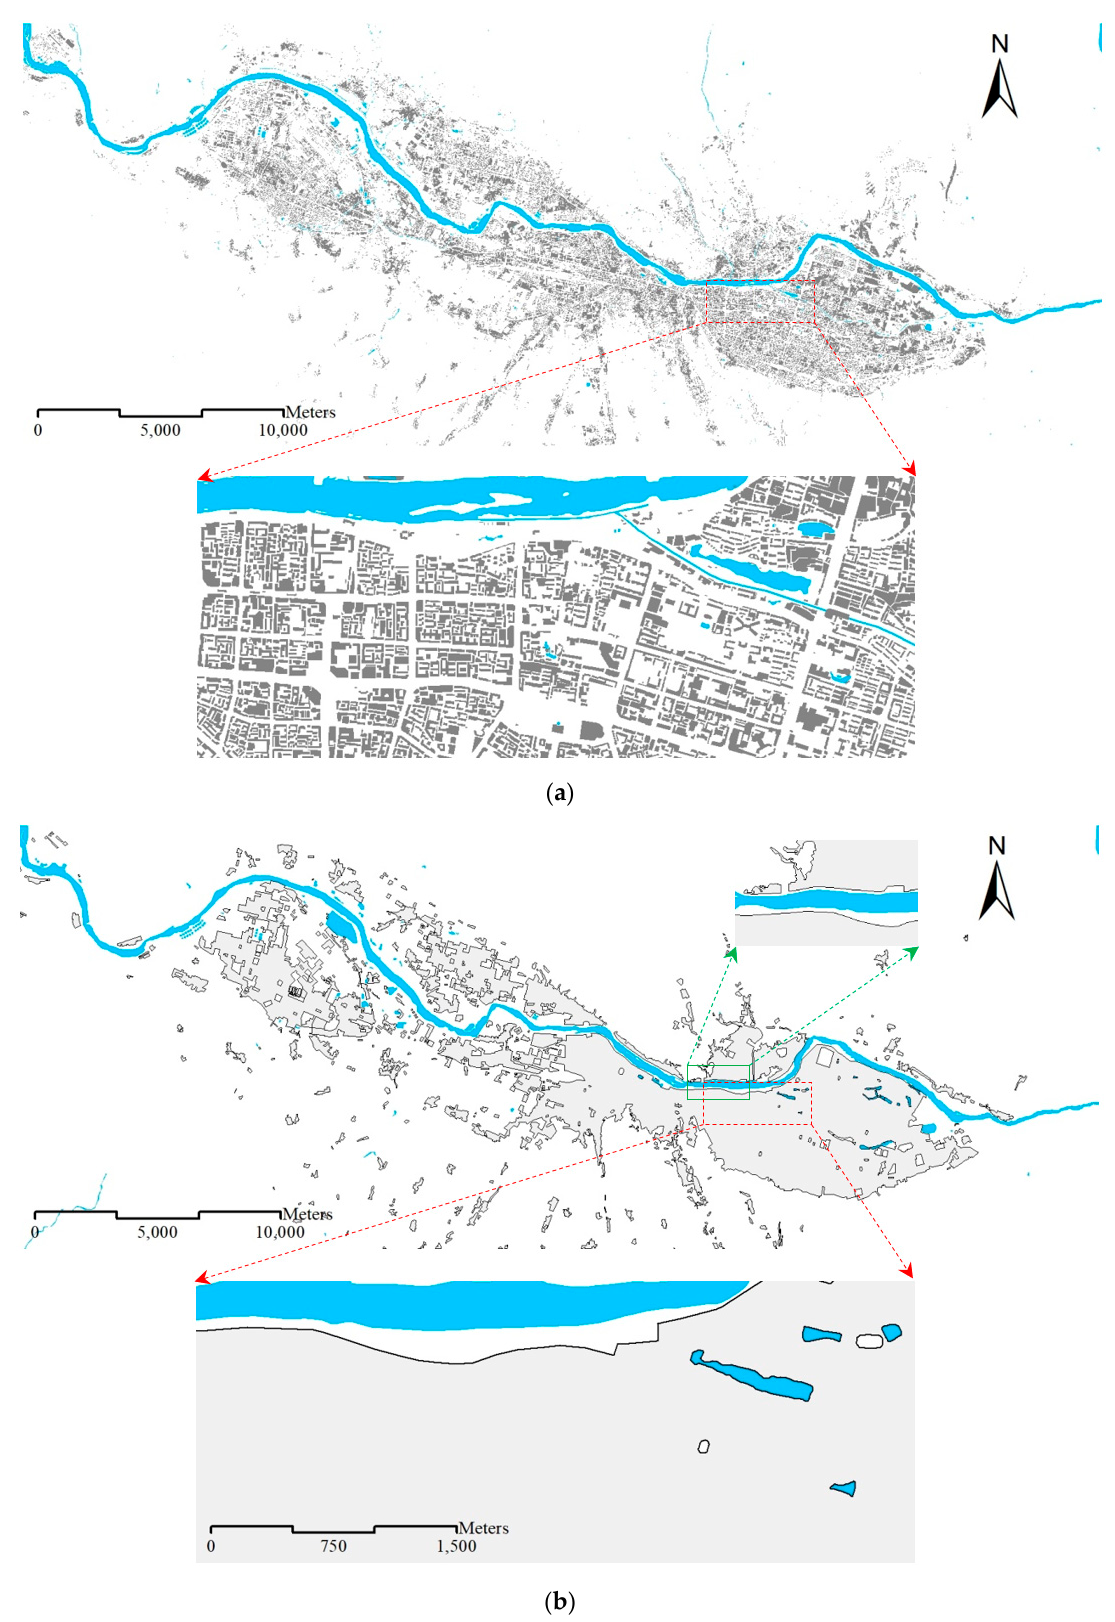
Figure 1. Vector datasets of Lanzhou City at the 1:10K and 1:50K scales: ( a ) 1:10K data and ( b ) 1:50K data.